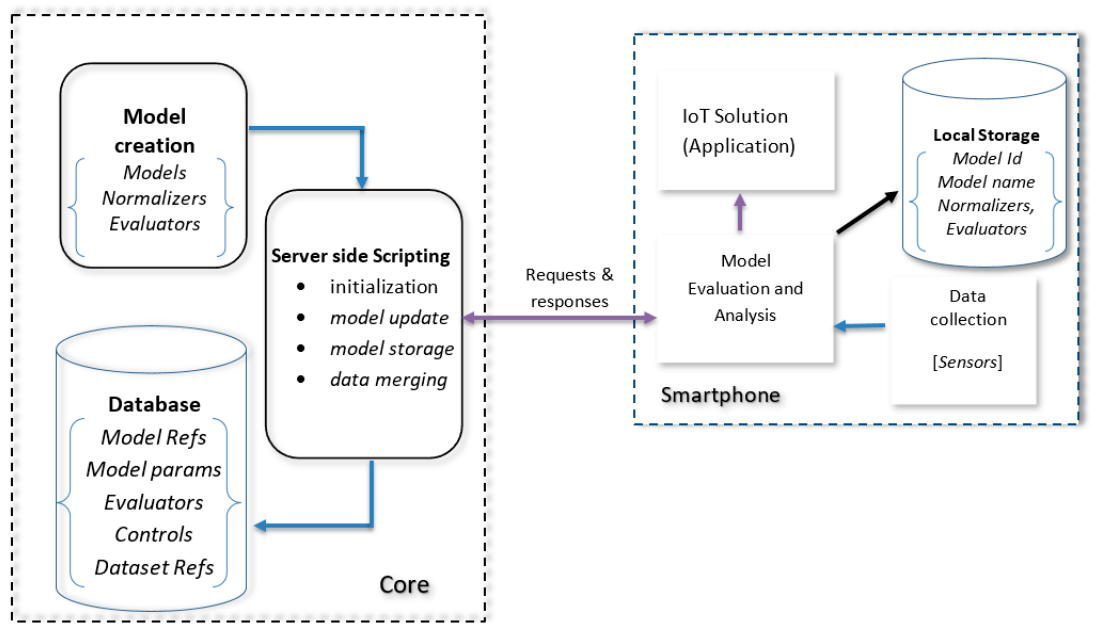
Figure 2. SMIoT components communication links, relationships and processes.